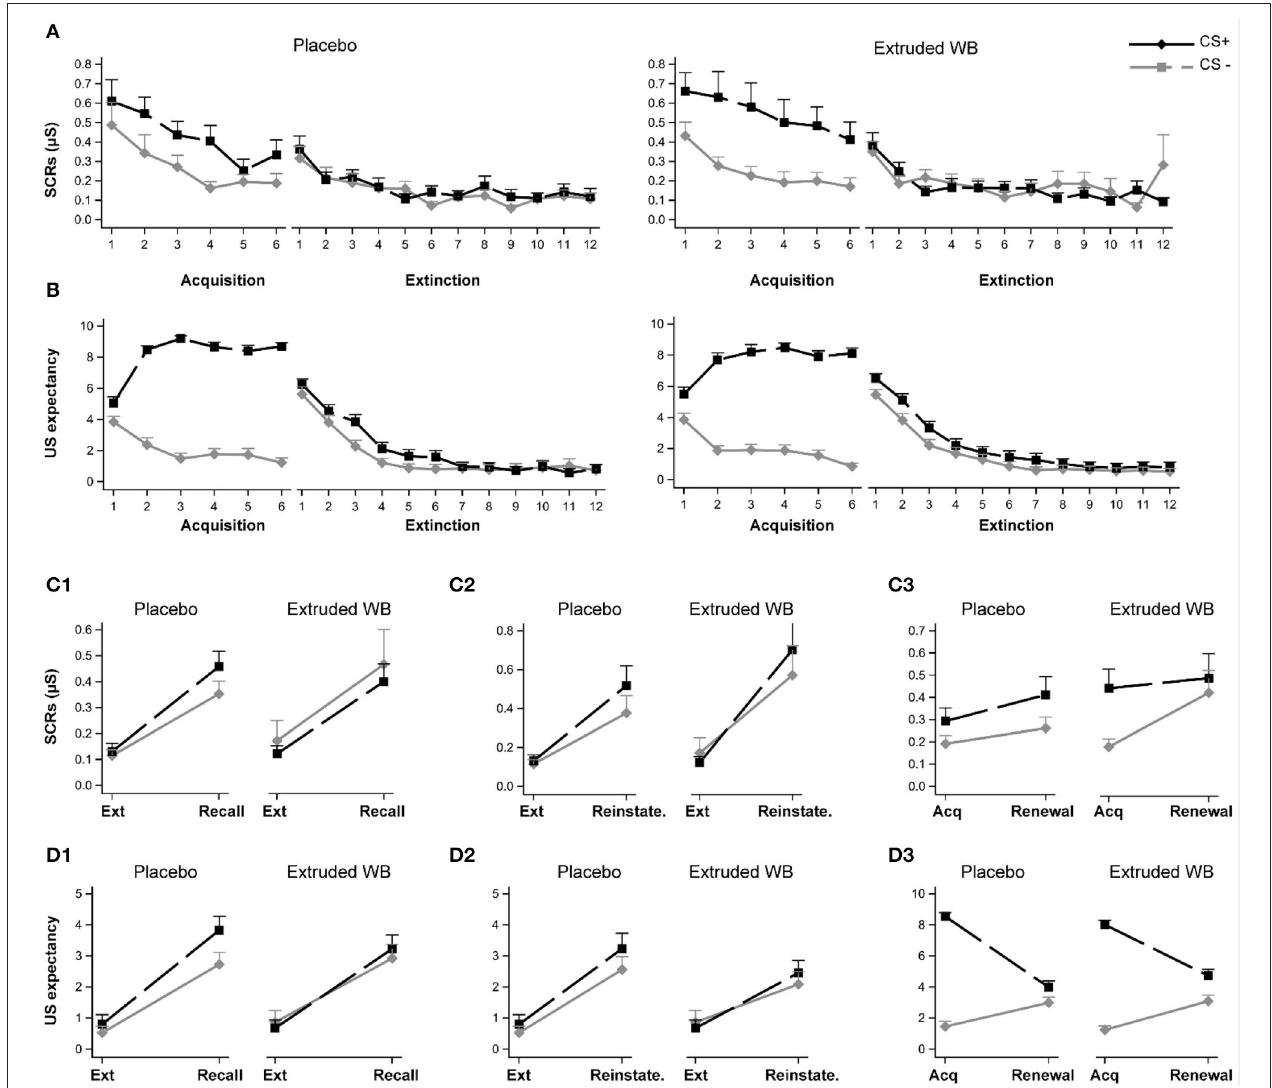
FIGURE 5 | Responses to the fear conditioning and extinction task. Participants underwent fear acquisition and extinction learning pre-intervention and return of fear were tested post-intervention by examining recall of extinction memory, reinstatement of extinction memory after the unsignaled US, and fear renewal. Participants in the placebo and extruded WB group exhibited similar fear acquisition and extinction patterns as indexed by the skin conductance responses (A) and subjective US expectancy ratings (B) . Consumption of placebo or extruded WB did not modulate skin conductance responses when testing recall of fear extinction memory (C1) , reinstatement of fear extinction memory (C2) , or fear renewal when the CSs were presented in the acquisition context (C3) . Similarly, subjective reports of US expectancy ratings were not modulated post-intervention (D1–D3) . Graphs show means ± SE . Ext: Extinction, Reinstate.: Reinstatement, US: unconditional stimulus, SCRs: skin conductance